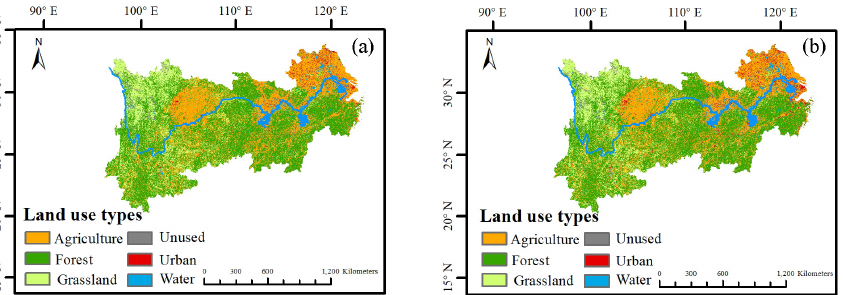
Figure 3. Spatial distribution of land use types in the YREB from 1999 to 2018 (( a ): 1999; ( b ): 2018).